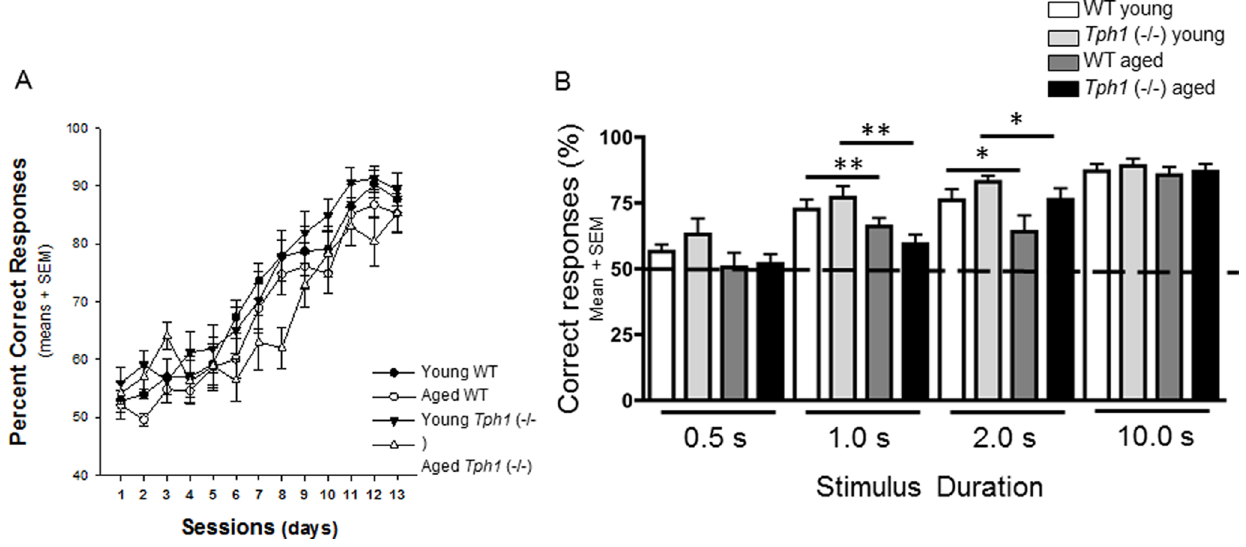
Figure 3. Lack of peripheral serotonin does not result in attention impairment. Ability to learn the association between the stimulus light and reward in WT and Tph1 ( 2 / 2 ) mice showed a strong trend indicating that aged Tph1 ( 2 / 2 ) mice may acquire this association more slowly, however, overtime they demonstrated successful learning across daily sessions (A). Overall, aged mice of both genotypes showed a significant deficit in performance during trials of 1 (**P , 0.01) and 2 seconds (*P , 0.05)